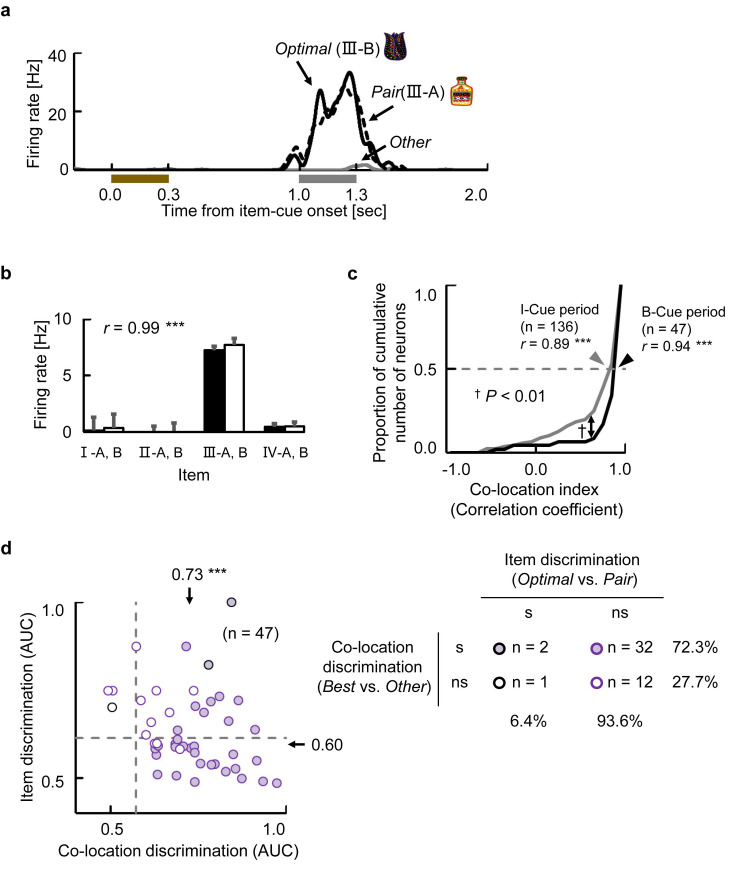
Retrieval signal after background-cue.(a) Example of an item-selective neuron with co-location effect. Black lines indicate SDFs in trials with the Optimal and its Pair items (i.e., best co-location items) of the neuron. Gray line indicates averaged response in the other trials (Other). Brown bar, presentation of the item-cue. Gray bar, presentation of the background cue. (b) Mean discharge rate and SEM of the same neuron during the background-cue period for each item. Black bars, set A. White bars, set B. r, co-location index. ***P < 0.0001, permutation test, 2-tailed. (c) Cumulative frequency histograms of the co-location index. Black line, item-selective neurons during B-Cue period. Gray line, item-selective neurons during I-Cue period. r, median of the co-location index values. ***P < 0.0001, Wilcoxon’s signed-rank test, 2-tailed. †P < 0.01, Kolmogorov–Smirnov test. (d) Two-dimensional scatter plot of AUC values for item-selective neurons during the background-cue period (n = 47). Same format as Fig 2G. ***P < 0.0001, Wilcoxon’s signed-rank test, 2-tailed. s, significant, P < 0.05, permutation test, 1-tailed. Source data are available in S1 Data. AUC, area under curve; B-Cue, background cue; I-Cue, item cue; ns, nonsignificant; SDF, spike density function.